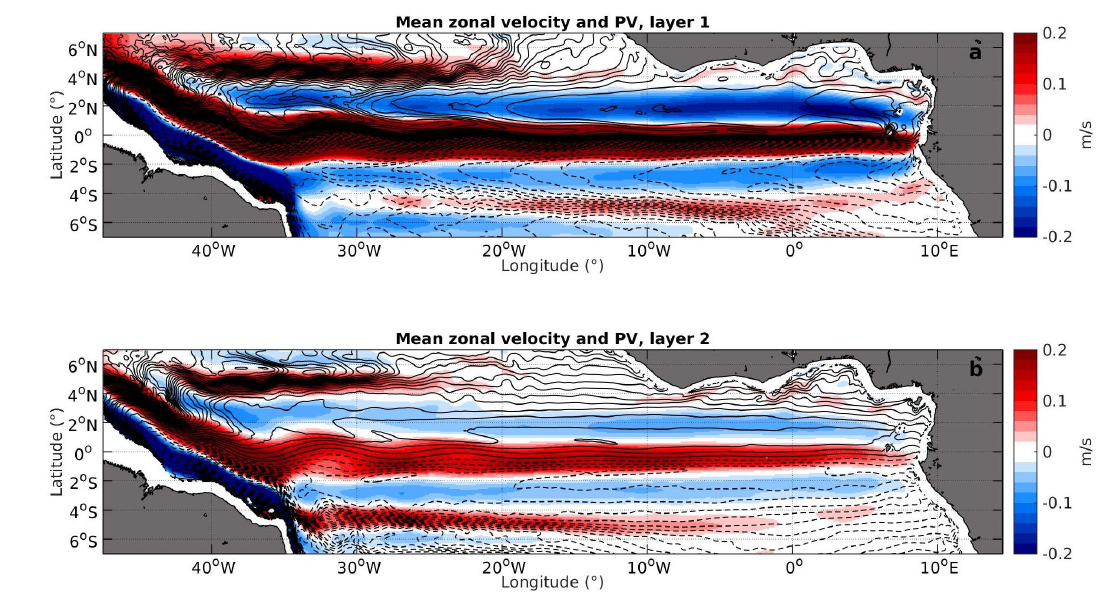
Figure 4. Time averaged zonal velocity U , vertically averaged within layer 1 ( a ), in color) and 2 (( b ), in color). The thin black lines are isolines of the mean PV field in each layer (negative values are dashed. The contour step is 2 × 10 − 6 s − 1 for layer 1 and 1 × 10 − 6 s − 1 for layer 2). The spatial distribution of PV is represented in color in Figure 5 for each layer (a and